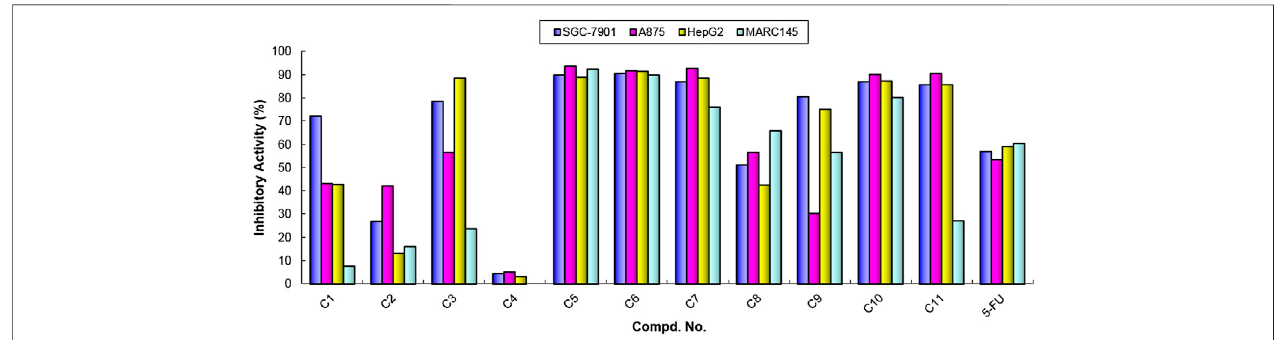
FIGURE 4 | Cytotoxic activities of compounds C1-11 at the concentration of 100 µM. Abbreviations: SGC-7901 — Human gastric cancer cell line; A875 — Human melanoma cell line; HepG2 — Human hepatocellular liver carcinoma cell line; MARC145 — A subclone of African green monkey kidney cell line MA-104; 5-FU — 5- Fluorouracil, used as a positive